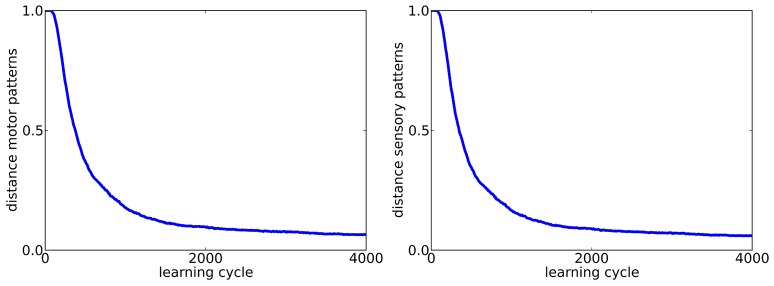
Learning curves for motor (left) and sensory (right) population (Ns = 200) in the case of exploration with a firing rate (rexplor = 2Hz) different from the tutor song (rtarget = 1Hz).